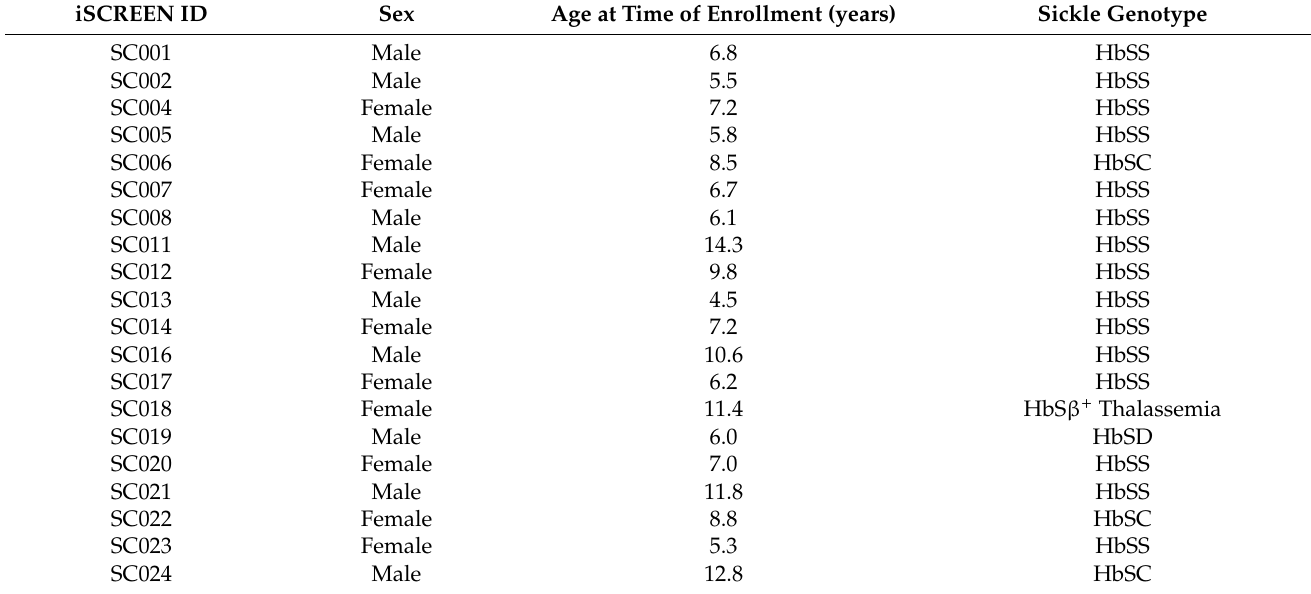
Table 1. Patient